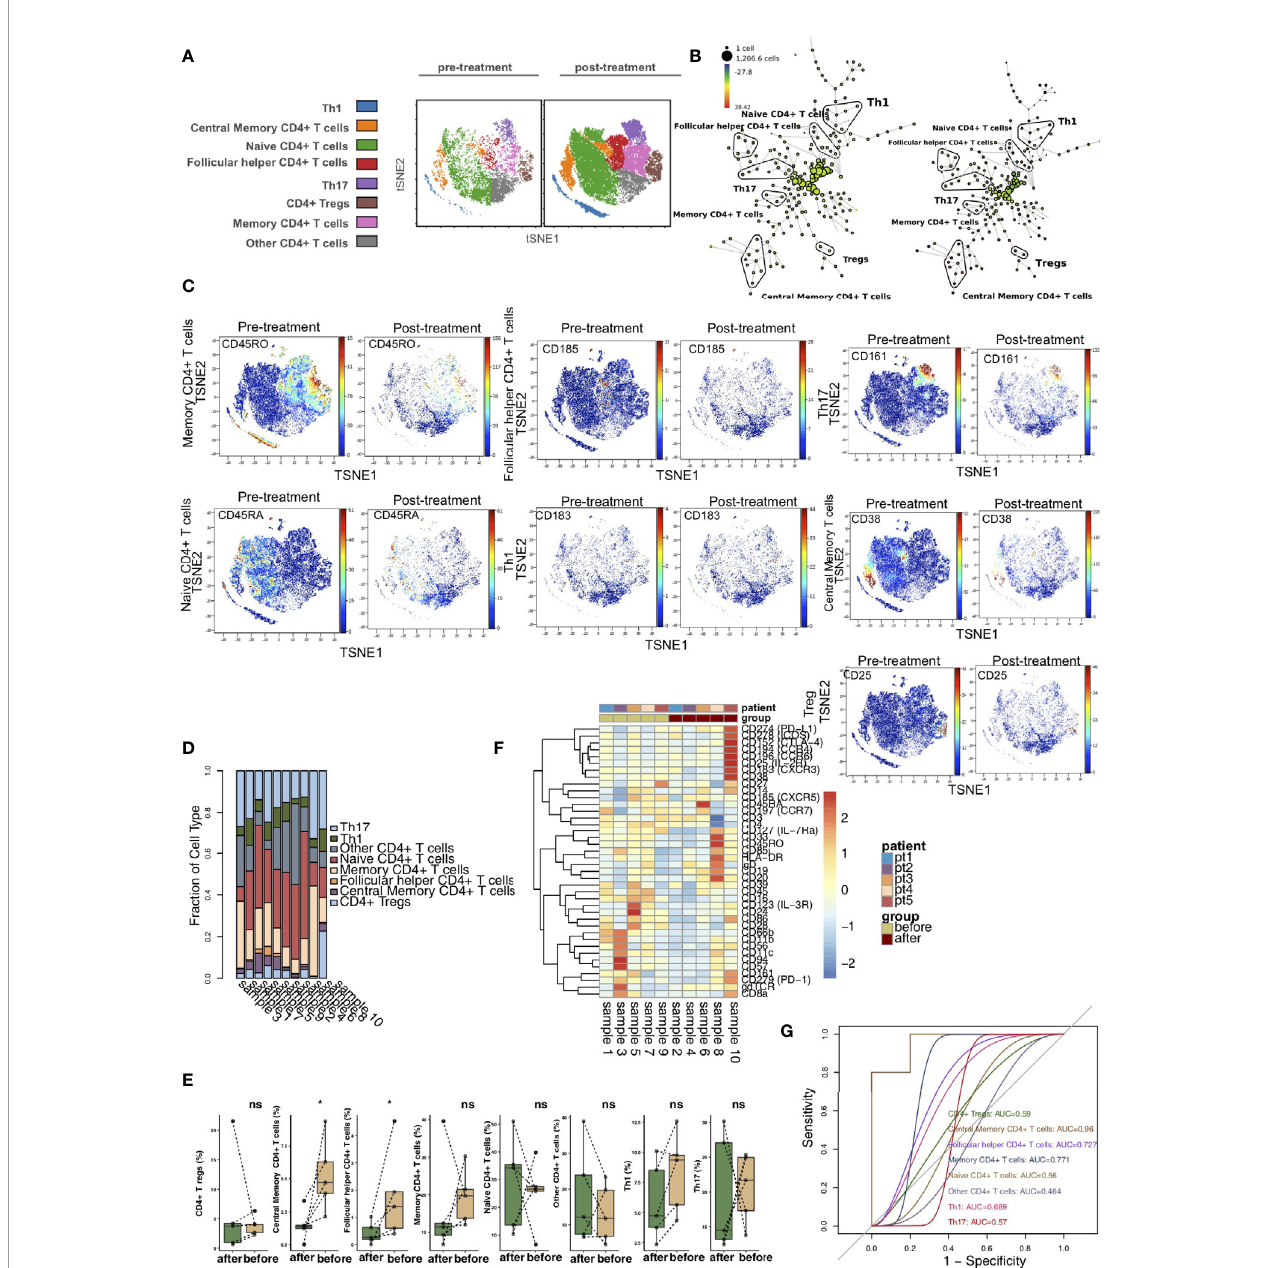
FIGURE 2 | CD4+ T cell subclusters in the kidney. (A) t-SNE plots of central memory CD4+ T cells, follicular helper CD4+ T cells, naive CD4+ Tregs, Th1 cells and Th17 cells. (B) In SPADE trees, node color is scaled to the fold change in CD38 content, and node size is scaled to the number of cells. (C) t-SNE plots of CD38, CD185, CD45RA, CD25, CD183 and CD161 expression in the pre- and posttreatment groups. (D) The proportions of CD4+ T cell subclusters in all samples. (E) Comparison of the proportions of CD4+ T cell subclusters between the pre- and posttreatment groups. (F) Heatmap of the marker expression of CD4+ T cells for all samples. (G) ROC curve of CD4+ T cell subclusters predicting the pre- and posttreatment groups. *P < 0.05; ns, not signi fi